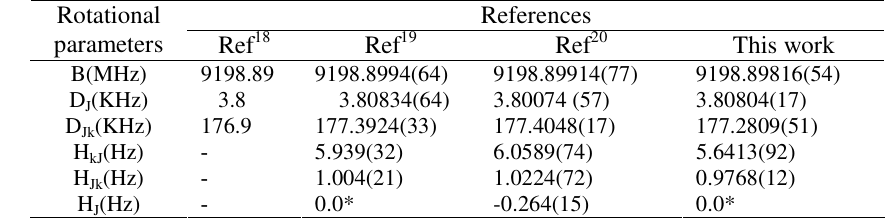
Table 3 . Comparison of rotational parameters of CH works